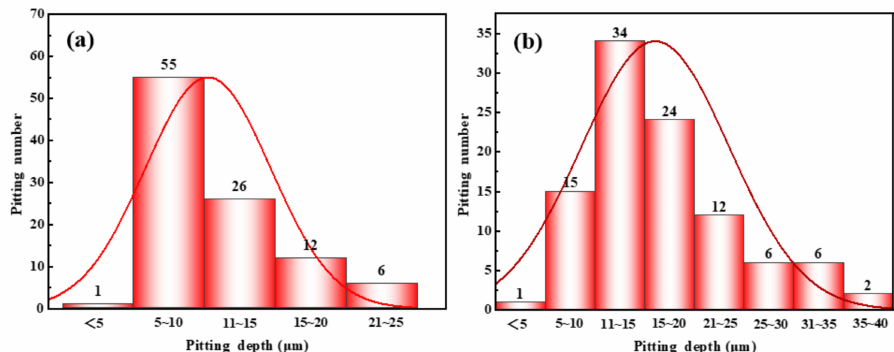
Figure 7. Localized corrosion depth of 2205 duplex stainless steel in acid solution system at different temperatures (( a ) 160 ◦ C; ( b ) 180 ◦ C).